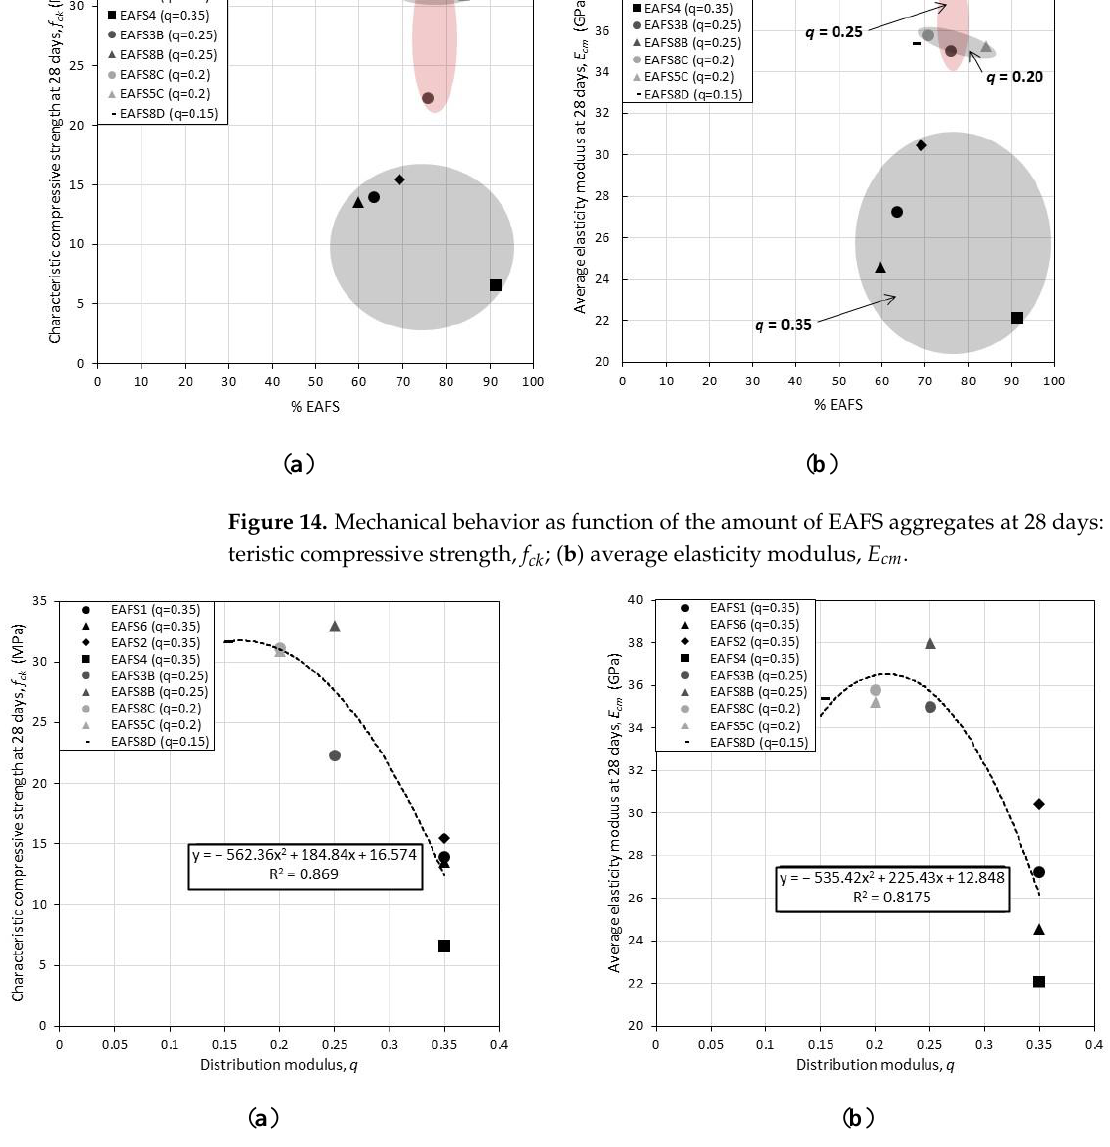
Figure 15. Evolution of the mechanical behavior as function of distribution modulus, q , at 28 days: ( a ) characteristic compressive strength, f ck ; ( b ) average elasticity modulus, E cm .